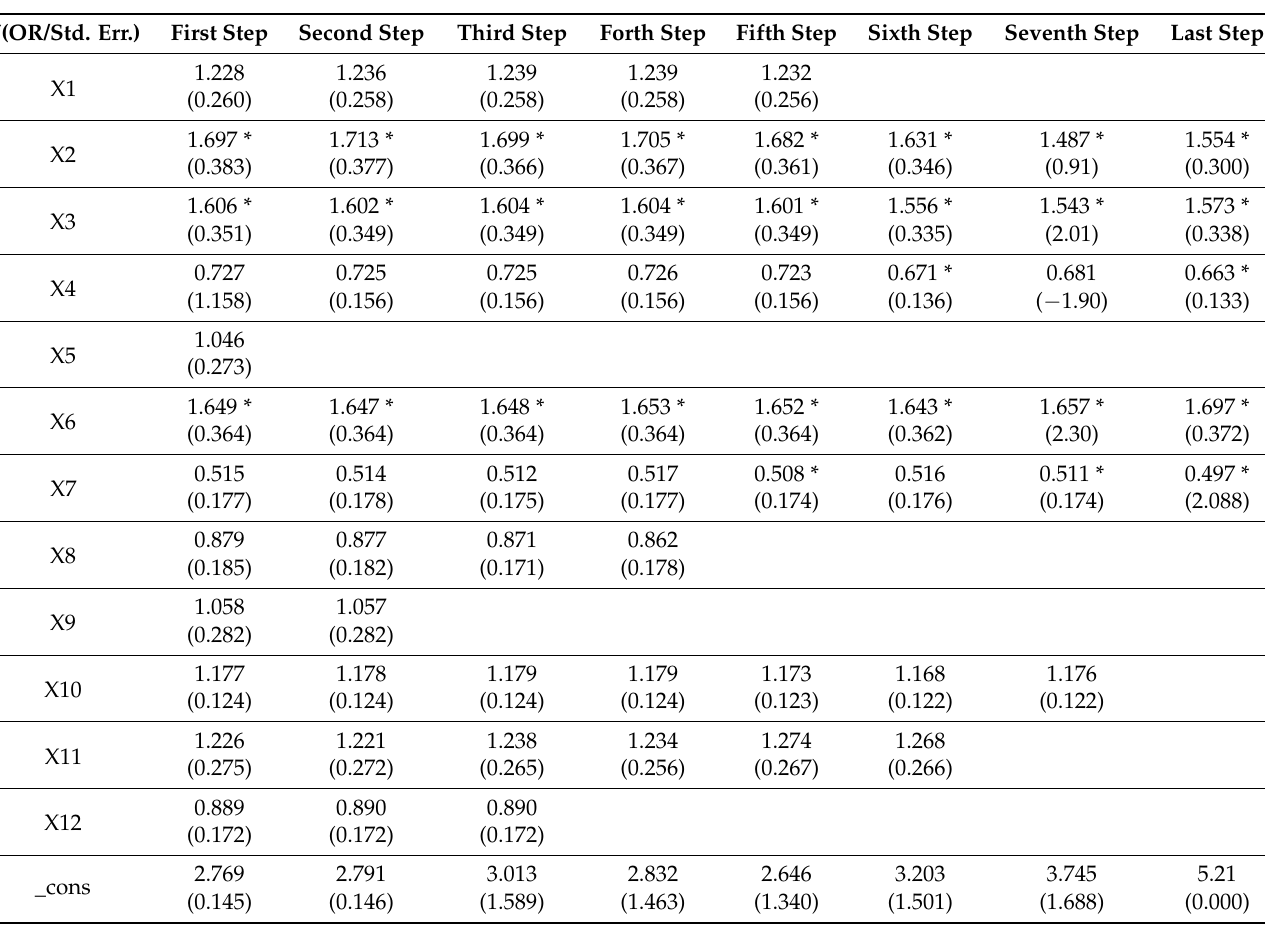
Table 4. Stepwise logistic regression of the indicators to HA.